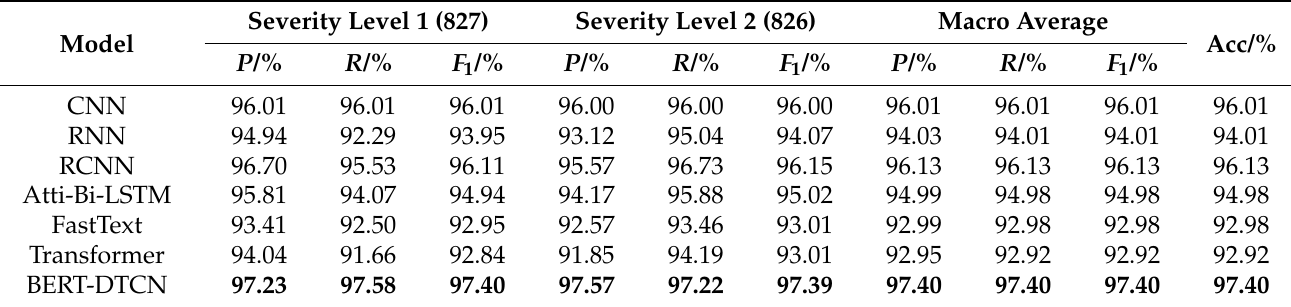
Table 6. Comparison of BERT-DTCN with competing approaches on the constructed catenary defect text database.